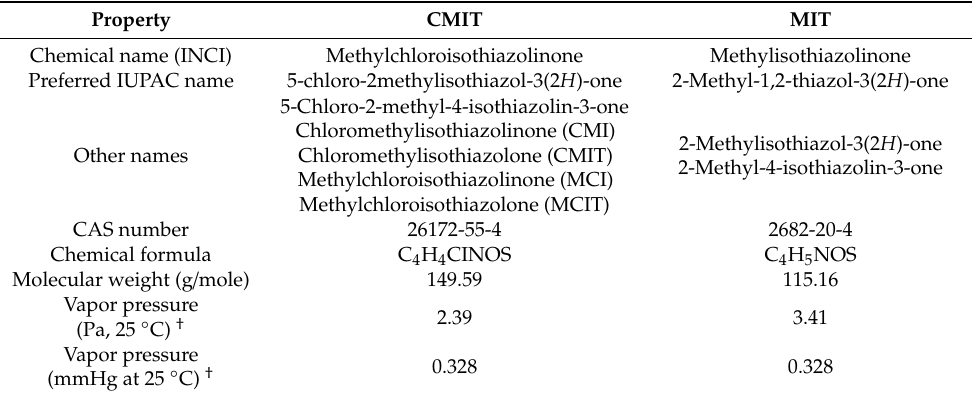
Table 1. Basic information on the physicochemical properties of CMIT and